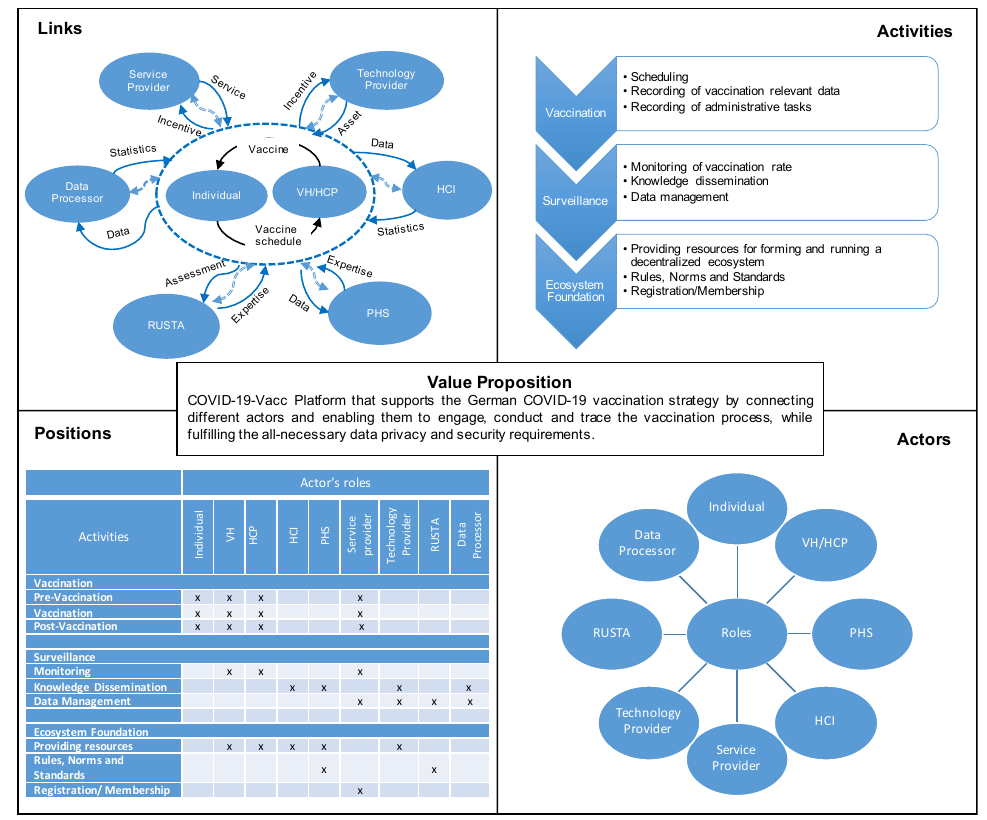
Figure 7. Ecosystem model of the COVID-19-Vacc